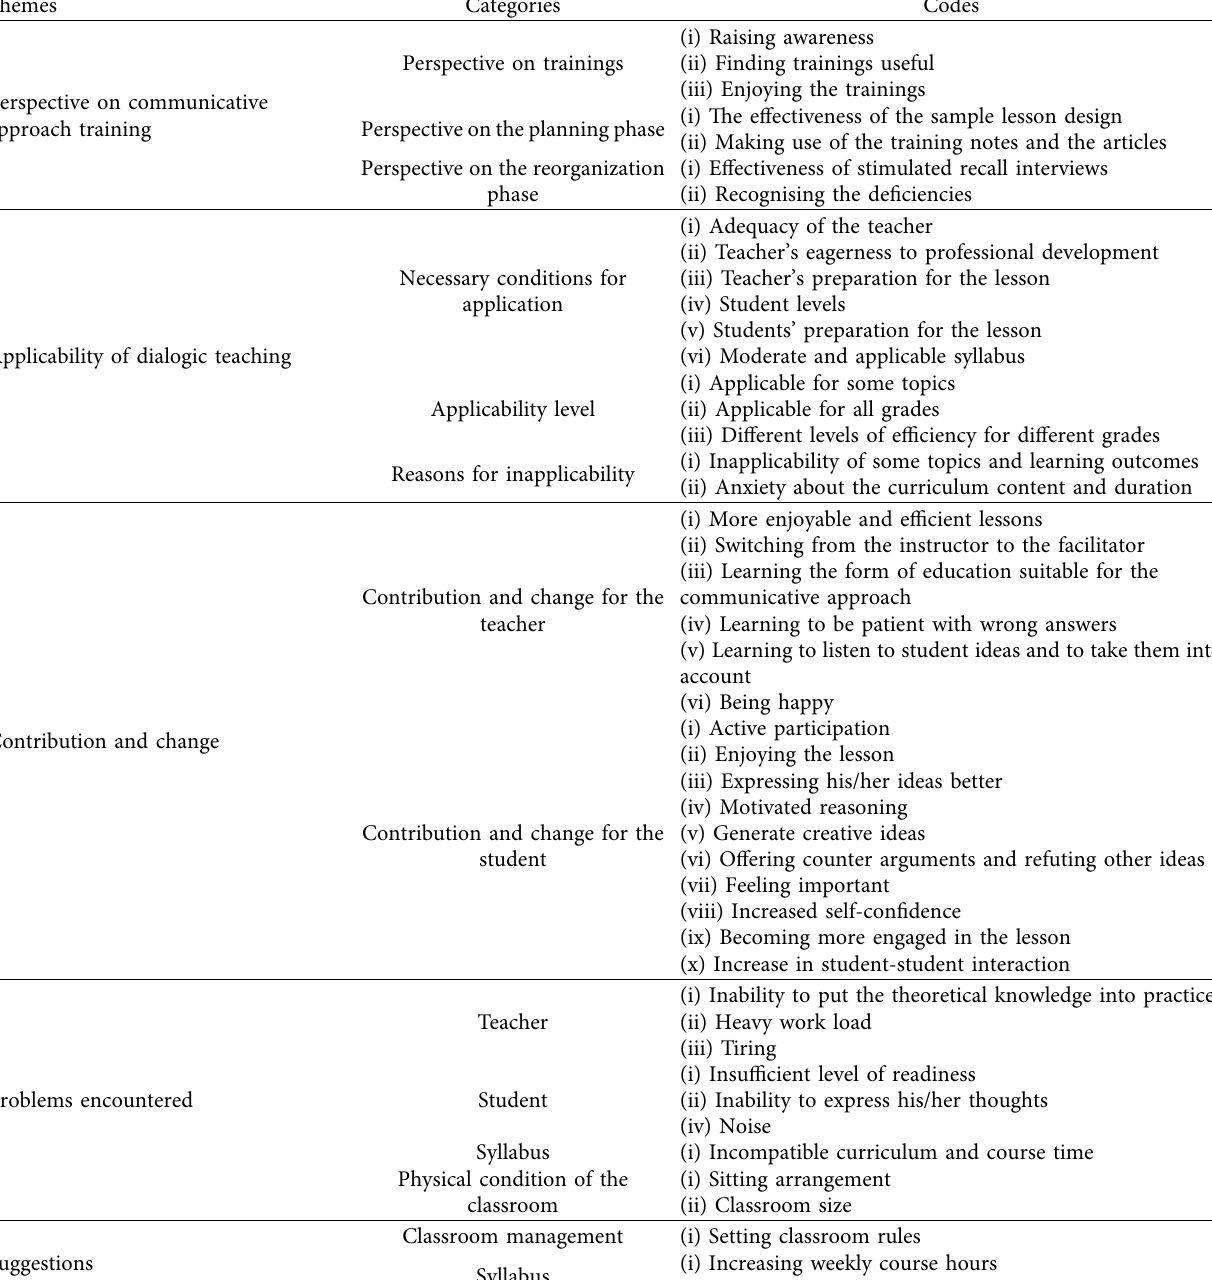
Table 2: Themes, categories, and codes obtained from the interviews regarding the action